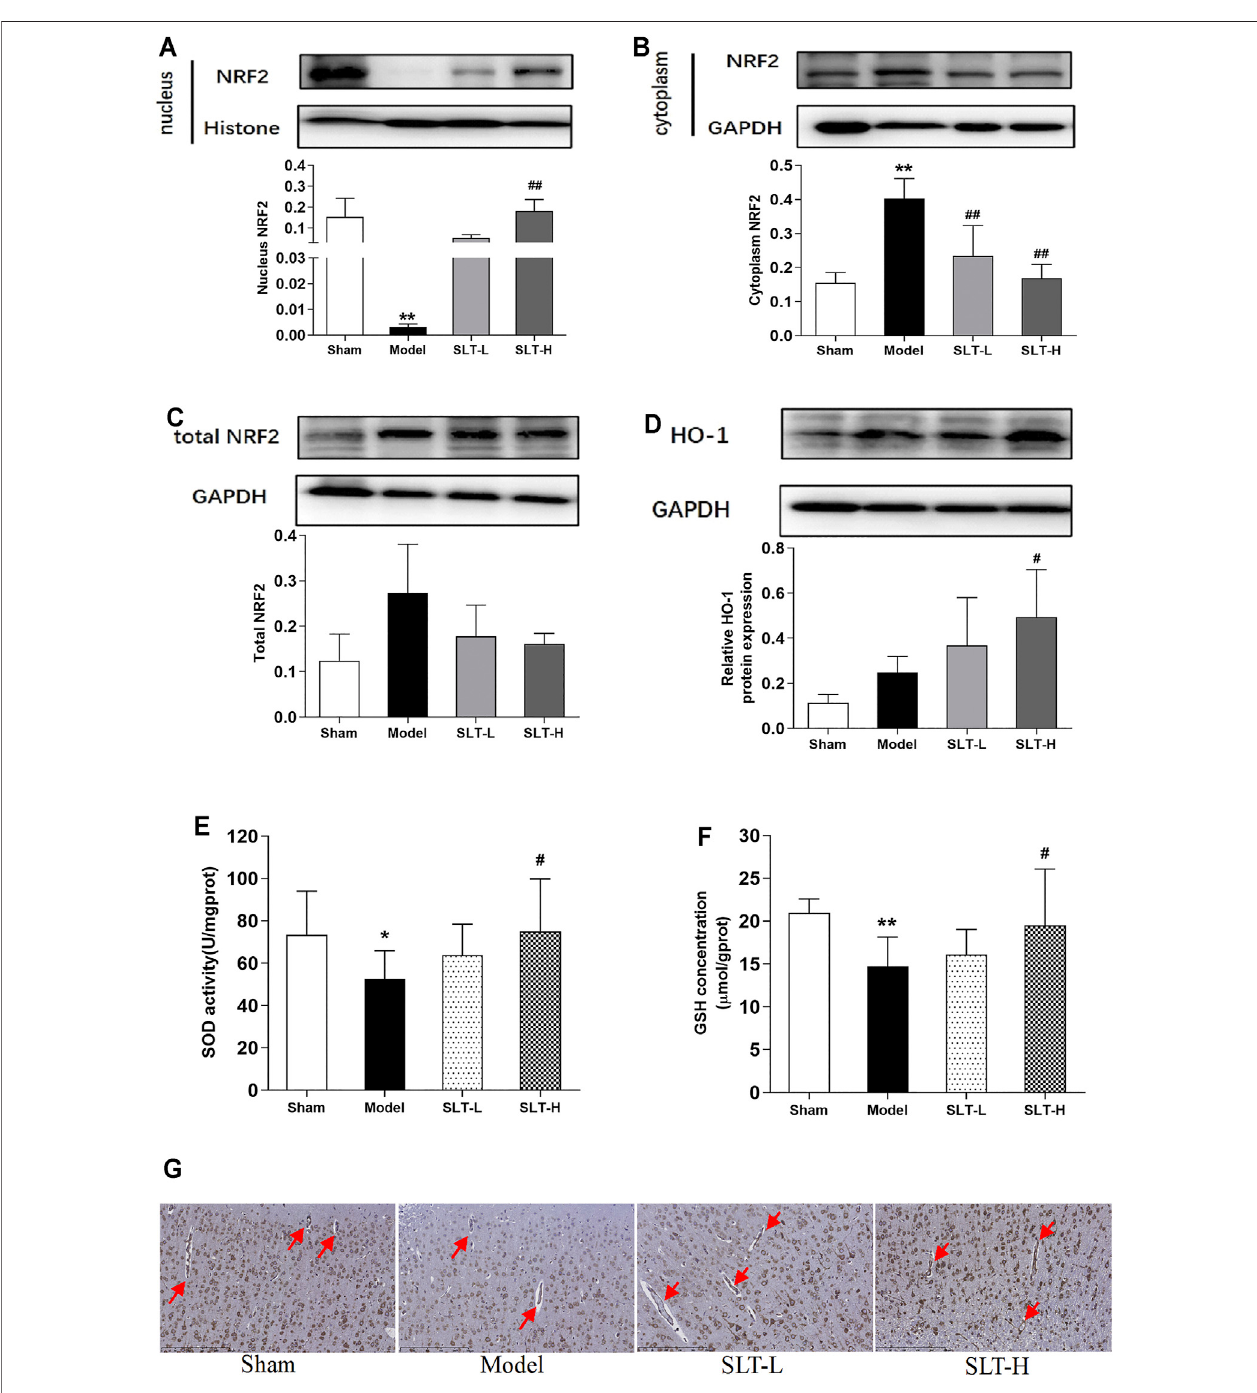
FIGURE3| SLTactivatedtheNrf2pathwayinthebrainafterischemia. (A – C) WesternblotassaysfortheproteinlevelsintheischemichemispheresofnucleusNrf2, cytoplasm Nrf2, and the total Nrf2( n (cid:1) 3). (D) HO-1expressions inthe ischemic hemispheres. (E) and (F) SOD activities and GSH contents inthe ischemic hemispheres ( n (cid:1) 8). (G) Immunochemistry examinationofHO-1 expressionsintheischemicregions.Redarrowsindicatethebloodvessels(scalebar (cid:1) 250 μ m).Dataareexpressed as mean ± SD. * p < 0.05, ** p < 0.01, vs. the sham group; # p < 0.05, ## p < 0.01, vs. the model group.